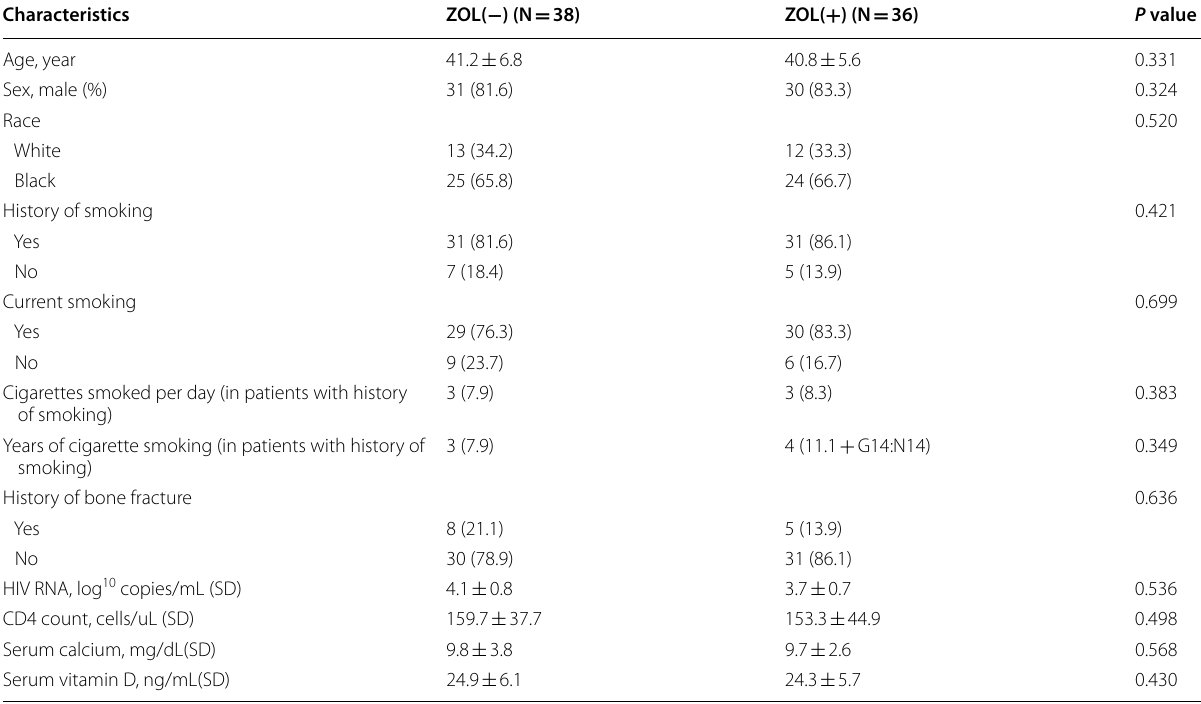
Table 1 Basic characteristics of HIV positive subjects Characteristics